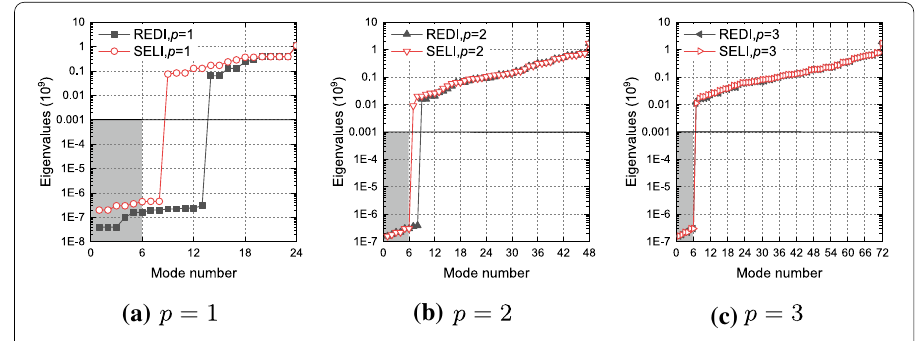
Fig. 6 Eigenvalues of hierarchical elements with reduced integration (REDI) and selective integration